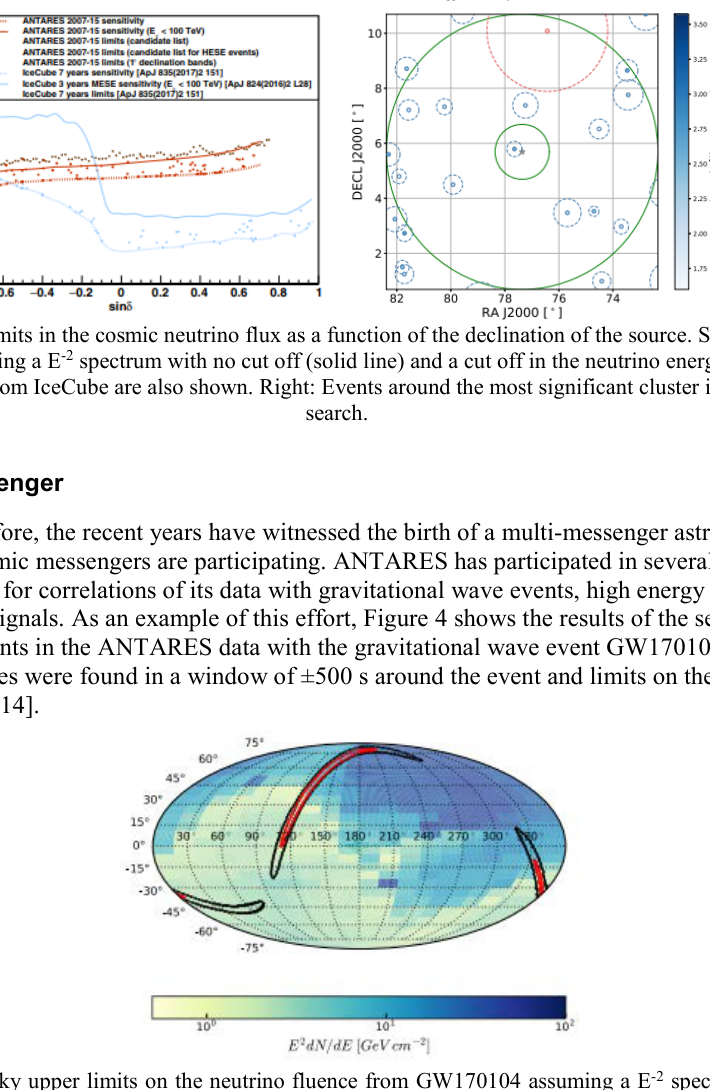
Figure 4 . All-sky upper limits on the neutrino fluence from GW170104 assuming a E -2 spectrum emitted at the source. Countrous for 68% and 90% CL are also shown. The skymap is shown in equatorial